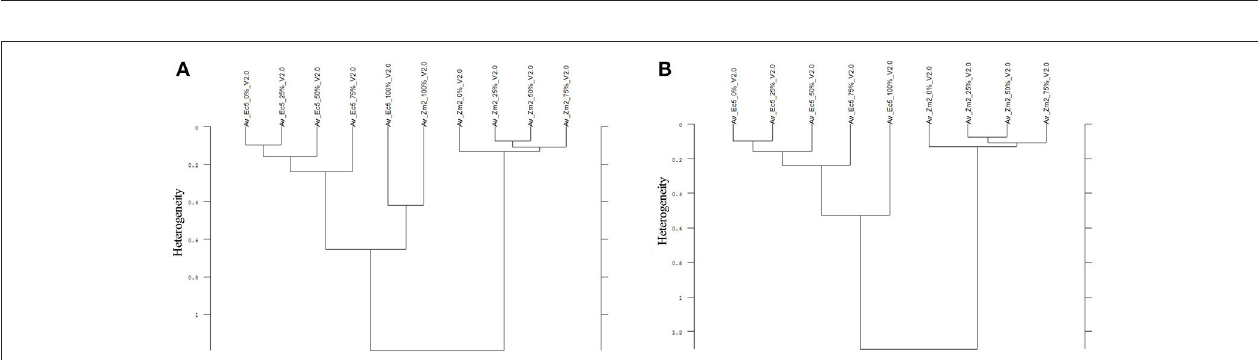
FIGURE 3 | Cluster analysis of the Av-spectra of the cultivar 2 of Zea mays (Zm2, maize) and the cultivar 5 of Echinochloa crus-galli (Ec5, barnyard grass) for the experiment 2-2 with all 10 Av-spectra (A) and with the omission of the 100% Av-spectra (root tip) of barnyard grass (Av_Ec5_100%) (B) . Cluster analysis was evaluated with the first derivation and vector normalization of the reduced frequency range (3,751–2,749 cm − 1 and 1,801–599 cm − 1 ), Ward’s algorithm and Euclidian distance. The Av-spectra are averages (Av) of FTIR-ATR spectra of the different root segments (100% root tip, 0% root basis etc.; see Figure 1 for scheme, Table 2 for n, Table 1 for names of cultivars and